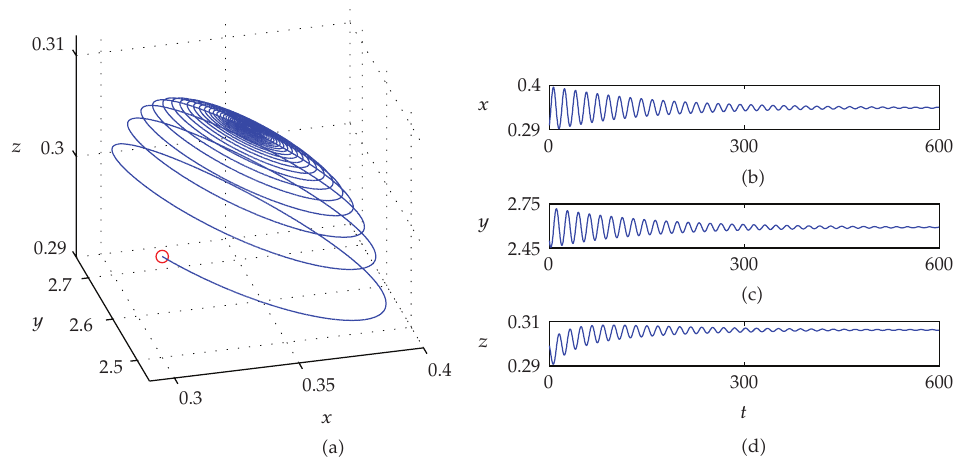
Figure 1: a (cid:7) 1 . 5, b (cid:7) 1, c 1 (cid:7) 0 . 6, c 2 (cid:7) 0 . 6, c 3 (cid:7) 0 . 7, c 4 (cid:7) 0 . 7, d 1 (cid:7) 0 . 1, d 2 (cid:7) 0 . 45, α 1 (cid:7) 1, α 2 (cid:7) 1 . 1, and β (cid:7) 1 . 1 and an initial condition (cid:3) 0 . 3 , 2 . 5 , 0 . 3 (cid:6) . (cid:3) a (cid:6) The trajectory of system (cid:3) 1.2 (cid:6) . (cid:3) b (cid:6) – (cid:3) d (cid:6) Time series for x (cid:3) t (cid:6) ,y (cid:3) t (cid:6) , and z (cid:3) t (cid:6) .